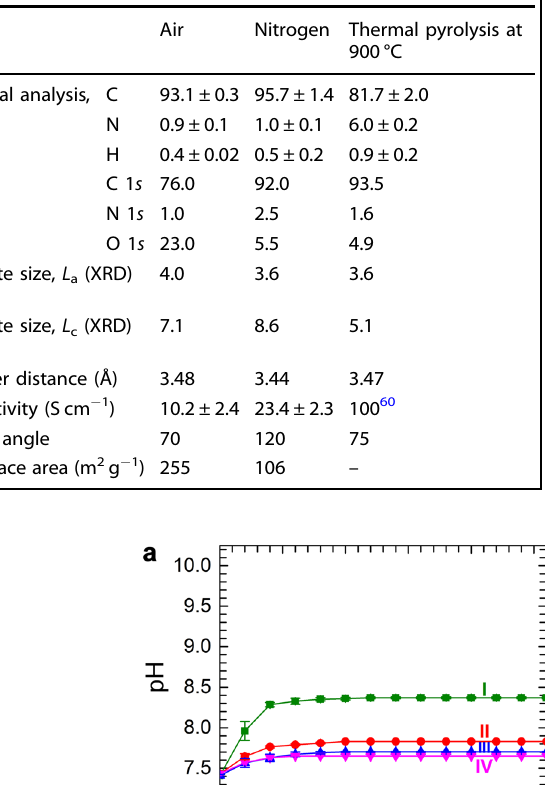
Table 2. Comparison of the properties of laser carbon to pyrolyzed Kapton